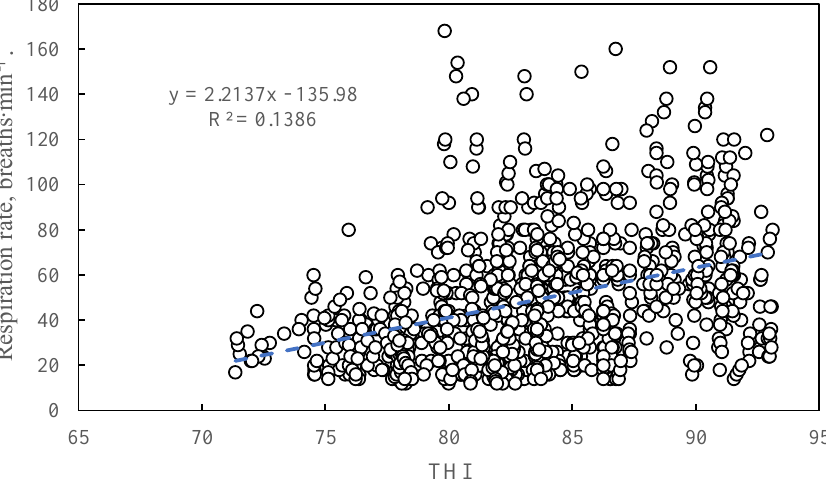
Figure 3. The correlation between temperature and humidity index and respiration rate. The THI